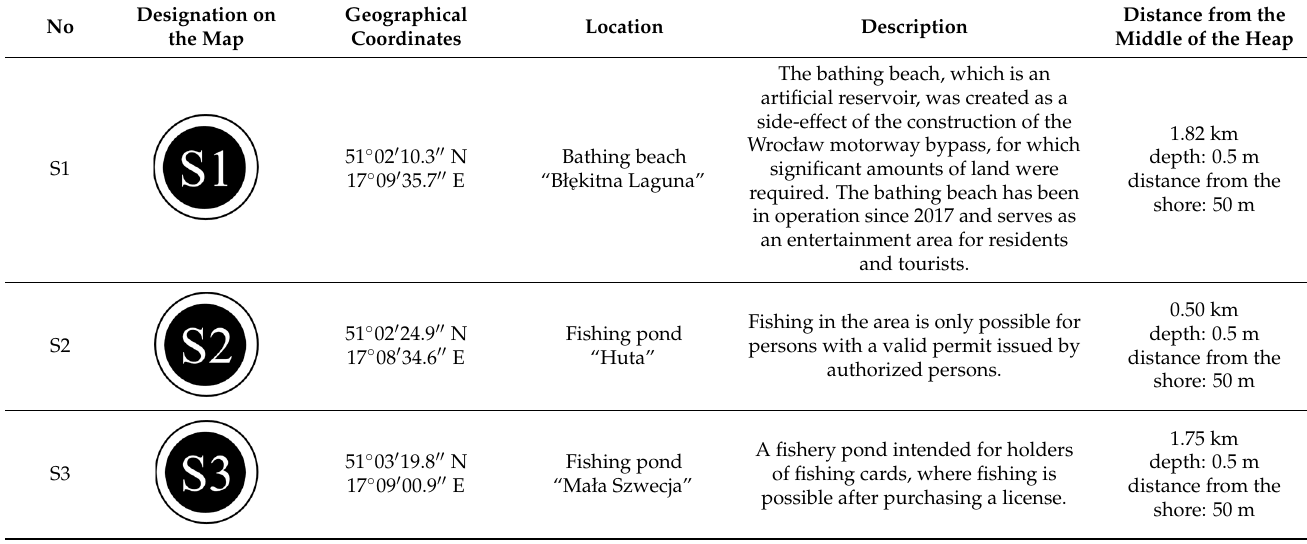
Table 1. Description of study areas.